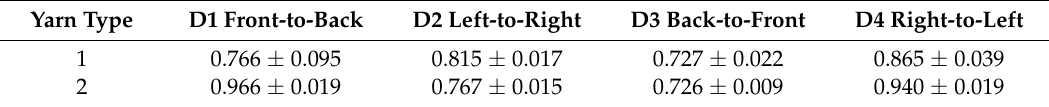
Table 3. Electrical resistance ( Ω /cm) of the MCEY embroidered circuit line (2.5 mm running stitches). Yarn